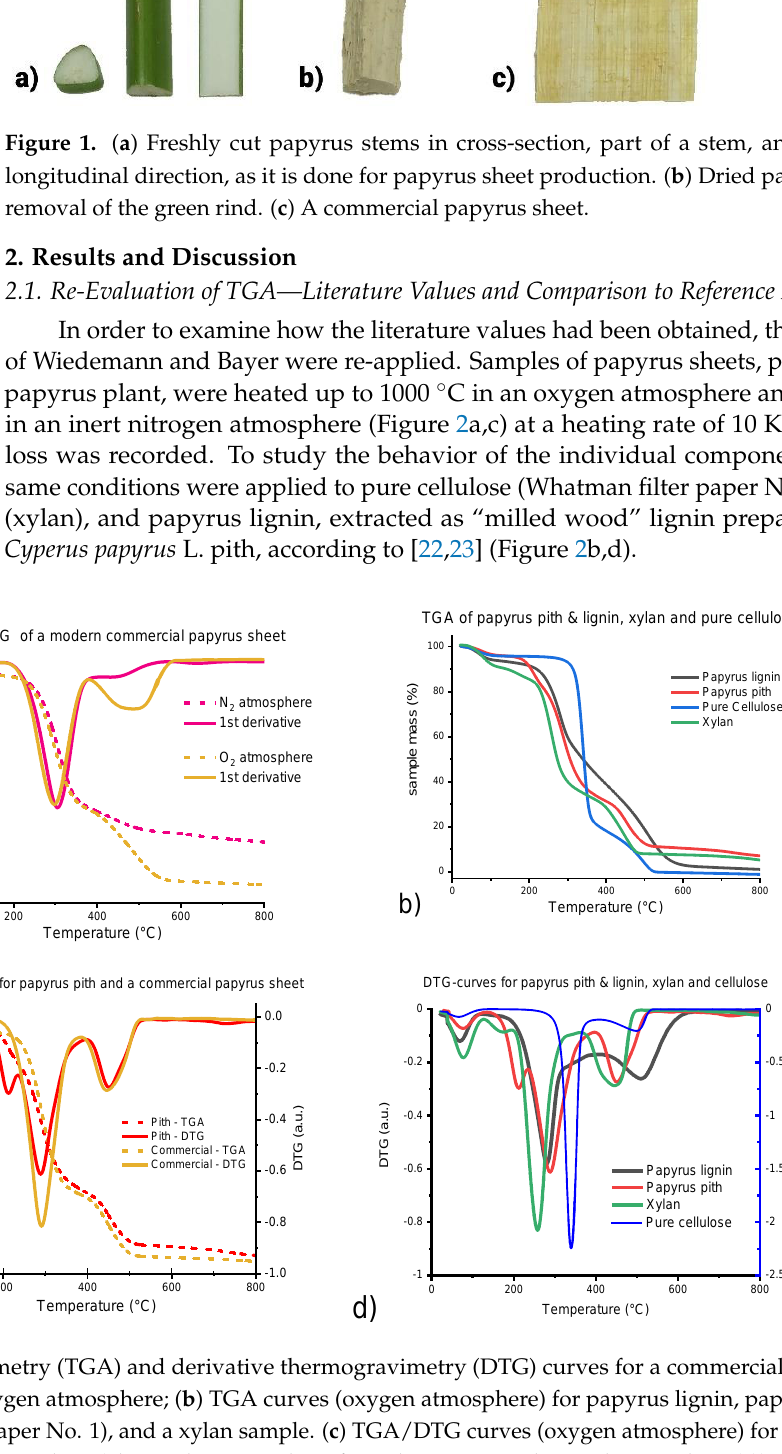
Figure 1. ( a ) Freshly cut papyrus stems in cross-section, part of a stem, and the stem cut in a longi- tudinal direction, as it is done for papyrus sheet production. ( b ) Dried papyrus pith, after the re- moval of the green rind. ( c ) A commercial papyrus sheet.